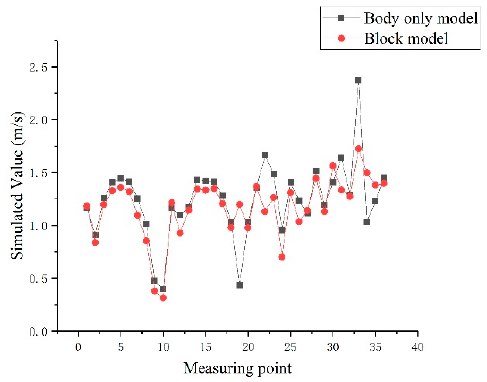
Figure 8. Comparison of e ffi ciency verification wind velocity between the body only model and the block model.